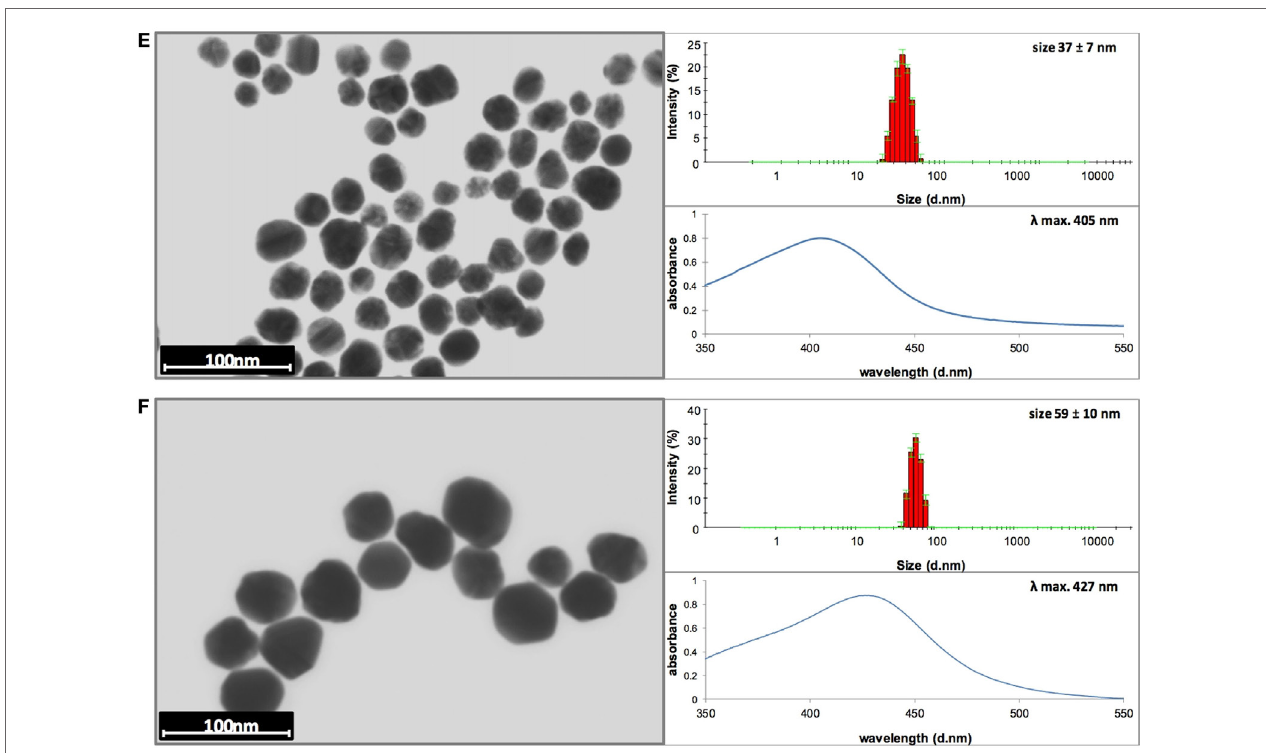
FigUre 1 | Dynamic light scattering (DLS) histograms, UV–vis, and scanning transmission electron microscopy images with size distribution histograms of AuNPs sized (a) 10 nm, (b) 34 nm, and (c) 62 nm, and AgNPs sized (D) 10 nm, (e) 37 nm, and (F) 59